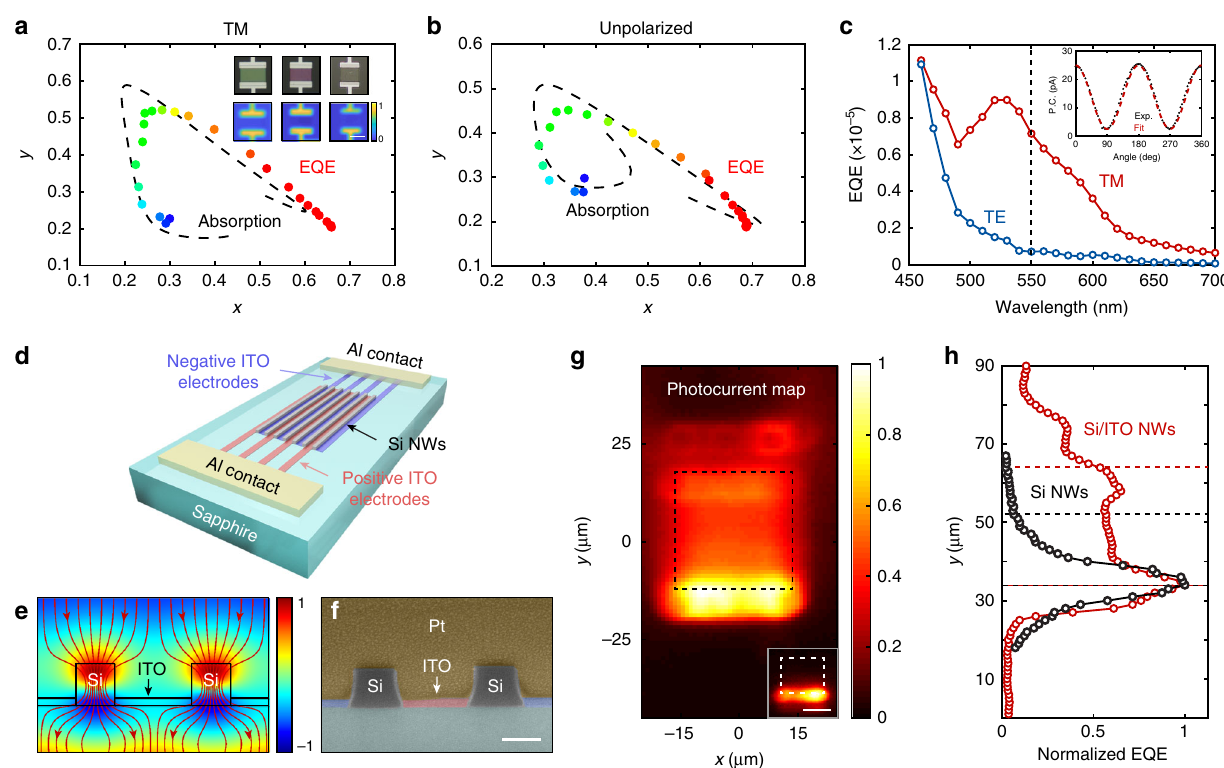
Fig. 3 Color and polarization detection and uniform photocurrent generation. a The color space de fi ned by the extracted photocurrent value from three fabricated NW array photodetectors for TM-polarized and b for unpolarized illumination. The dashed back line shows the simulated absorption ratio as a function of wavelength between 450 and 700 nm. The colored dots show the measured EQE ratio from 460 to 700 nm in steps of 10 nm. The x -axis is de fi ned as I R /( I R + I G + I B ) and y -axis is de fi ned as I G /( I R + I G + I B ). For monochromatic illumination, the photocurrent ratio is equivalent to the absorption ratio and the EQE ratio. Insets: Re fl ection optical images (top) and re fl ection maps (bottom) of three NW photodetectors. The re fl ection maps are taken at 625, 550, and 485 nm, respectively. Scale bar: 20 μ m. c Measured “ green ” pixel EQE as a function of wavelength for two orthogonal polarizations. Inset: Measured photocurrent at 550 nm as a function of the angle between the incident polarization and the NW orientation. d Schematic of a Si/ITO interdigitated NW array photodetector. Photocurrent is extracted transversely across the Si NWs. e Electric fi eld distribution and the power fl ow lines of the proposed Si/ITO interdigitated photodetectors under normal incidence. f False-color cross-section SEM image of the as-fabricated interdigitated Si/ ITO NW array photodetector. Scale bar: 100 nm. g Normalized photocurrent map of the interdigitated NW array photodetector (inset: photocurrent map for bare Si NW array photodetector. Scale bar: 20 μ m) at a wavelength of 625 nm for TM polarization. The black (white) dashed box shows the position of the Si/ITO interdigitated (Si) NW array detector. h Normalized EQE of Si/ITO interdigitated NW array detector (red) and bare Si NW array detector (black) as a function of the position along the NWs for x = 0. Two dashed red (black) lines indicate the Si/ITO interdigitated NW array detector (Si NW array detector)